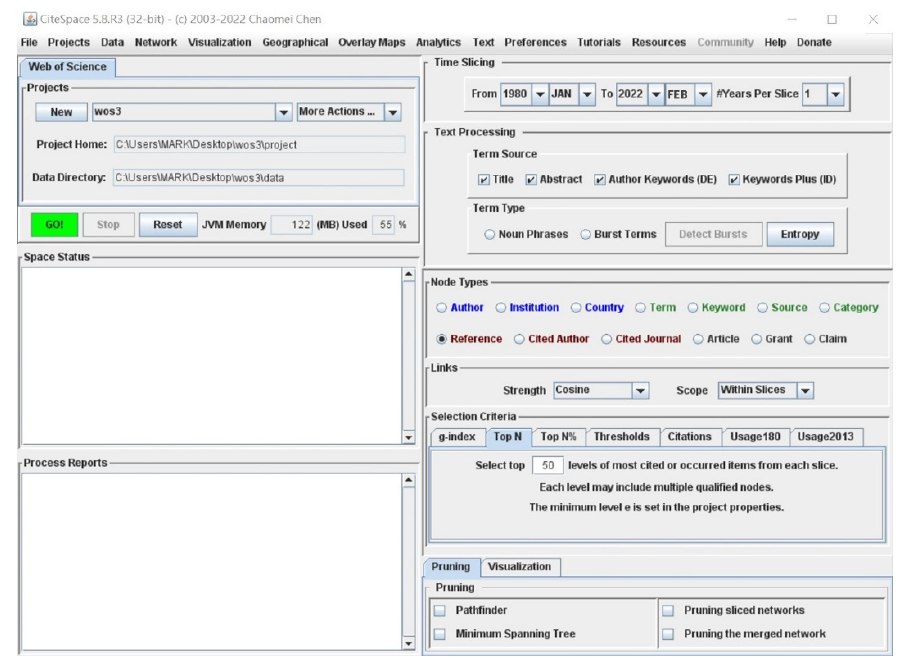
Figure 1. The operating interface of CiteSpace.